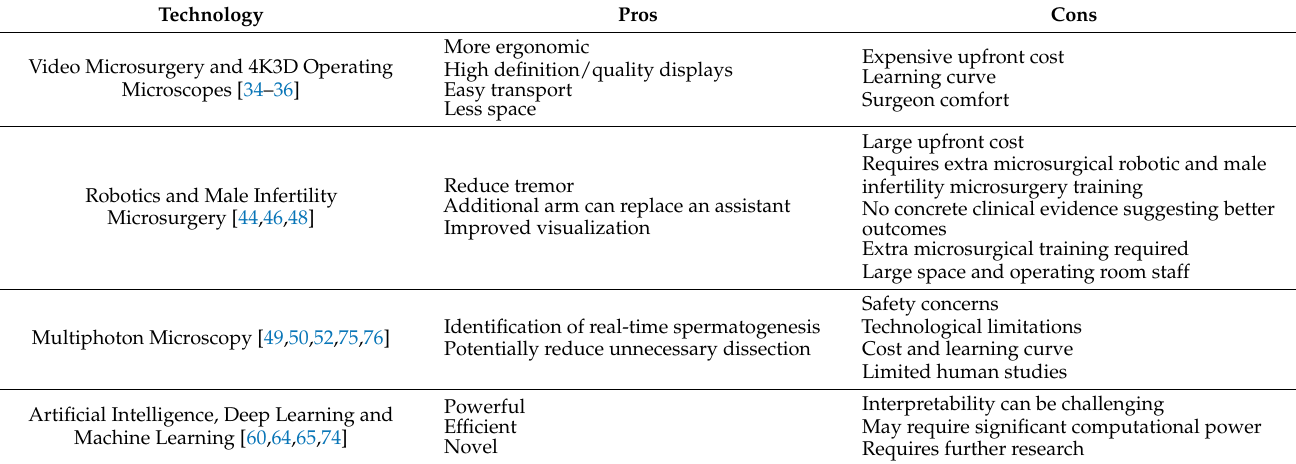
Table 1. Pros and cons of technologies in male infertility